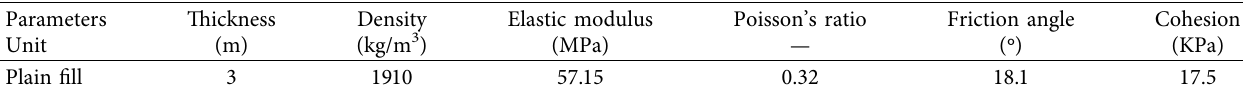
Figure 5: Dimensions of the simulation model: (a) whole model, (b) underpass structure, and (c) shear keys. Table 1: The mechanical and physical parameters of the plain